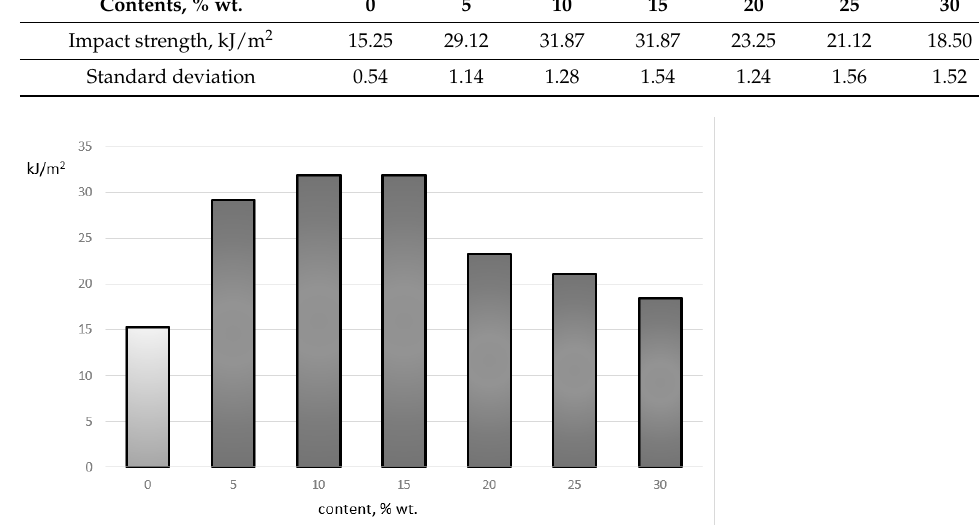
Table 7. Impact strength depending on the content of the content of the Crusil M20 filler. Contents, % wt.